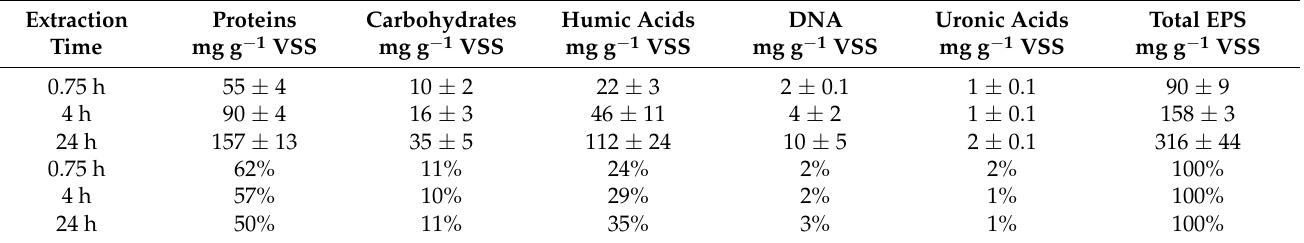
Table 1. EPS biochemical composition and percentages, n =